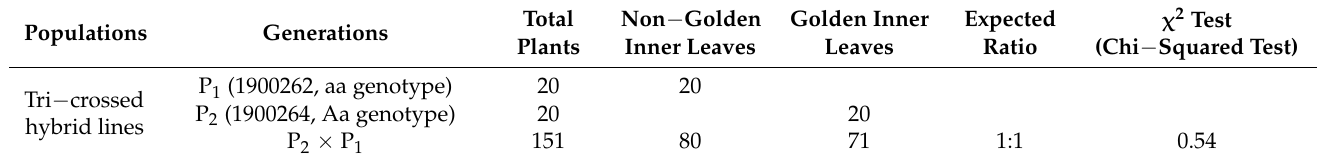
Table 1. Genetic analyses of the tri − crossed hybrid